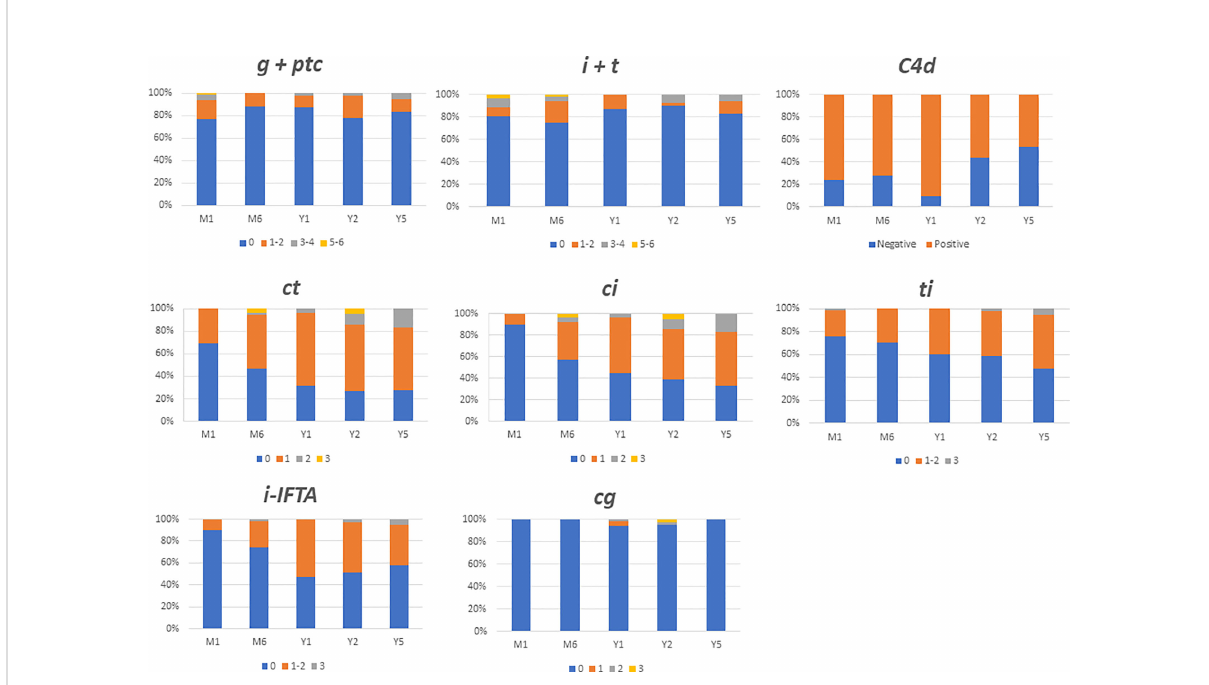
FIGURE 1 Main histological fi ndings during 5 years follow up after ABO incompatible kidney transplantation. Data are expressed in each colomn with the percentage of patients presenting the same banff score. i, interstitial in fl ammation; t, tubulitis; g, glomerulitis; ptc, peritubular capilaritis; ci, chronic interstial fi brosis; ct, tubular atrophy; cg, glomerular basement membrane double